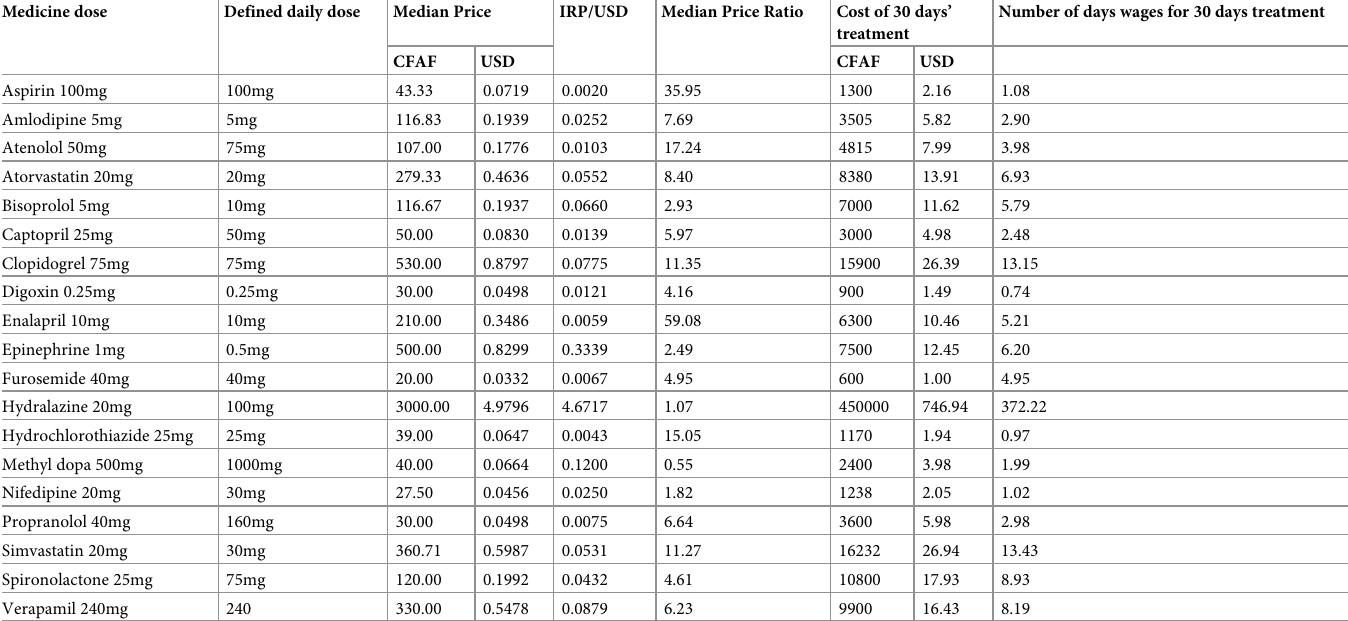
Table 3. Median price, median price ratio and affordability of cardiovascular medicines. Medicine dose